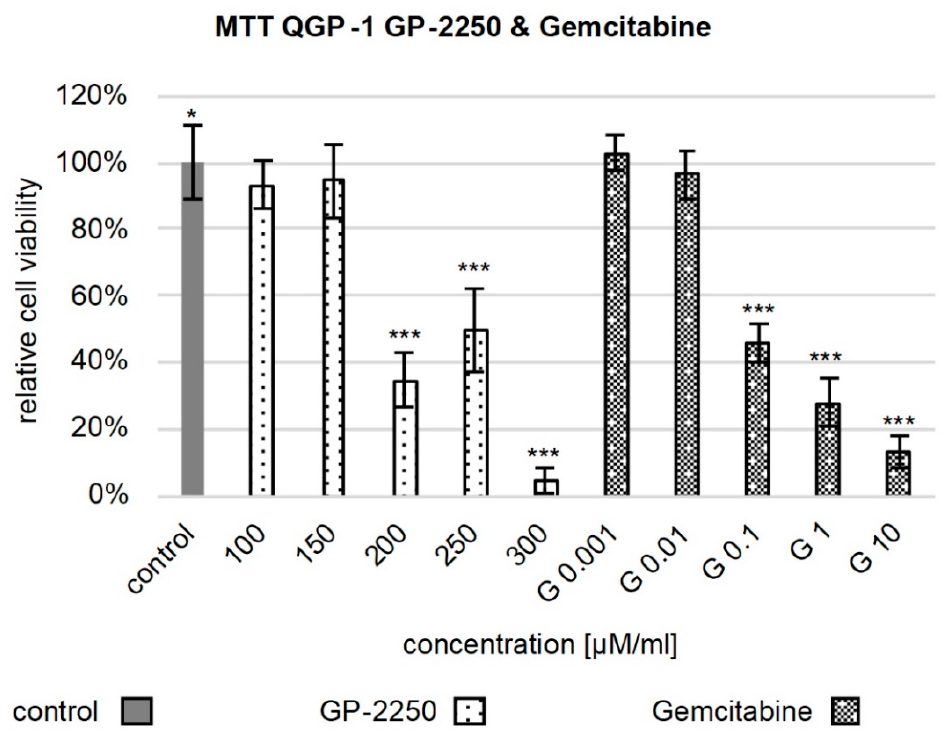
Figure 1. Cell viability assay of QGP-1 monotherapy. Figure 1 shows the reduction in cell viability observed in the MTT assay after treatment with 100 µM GP-2250, 150 µM GP-2250, 200 µM GP-2250, 250 µM GP-2250, 300 µM GP-2250, 0.001 µM Gemcitabine, 0.01 µM Gemcitabine, 0.1 µM Gemcitabine, 1 µM Gemcitabine and 10 µM Gemcitabine compared to the untreated control. Error bars show the standard deviation. p -values are indicated as follows: *** p ≤ 0.001, * p ≤ 0.05. Combining GP-2250 and Gemcitabine led to a highly significant synergism in the Similarly, the dose response to Gemcitabine and GP-2250 was determined in BON-1 reduction in cell viability in both the QGP-1 and BON-1 cells (Figure 2).